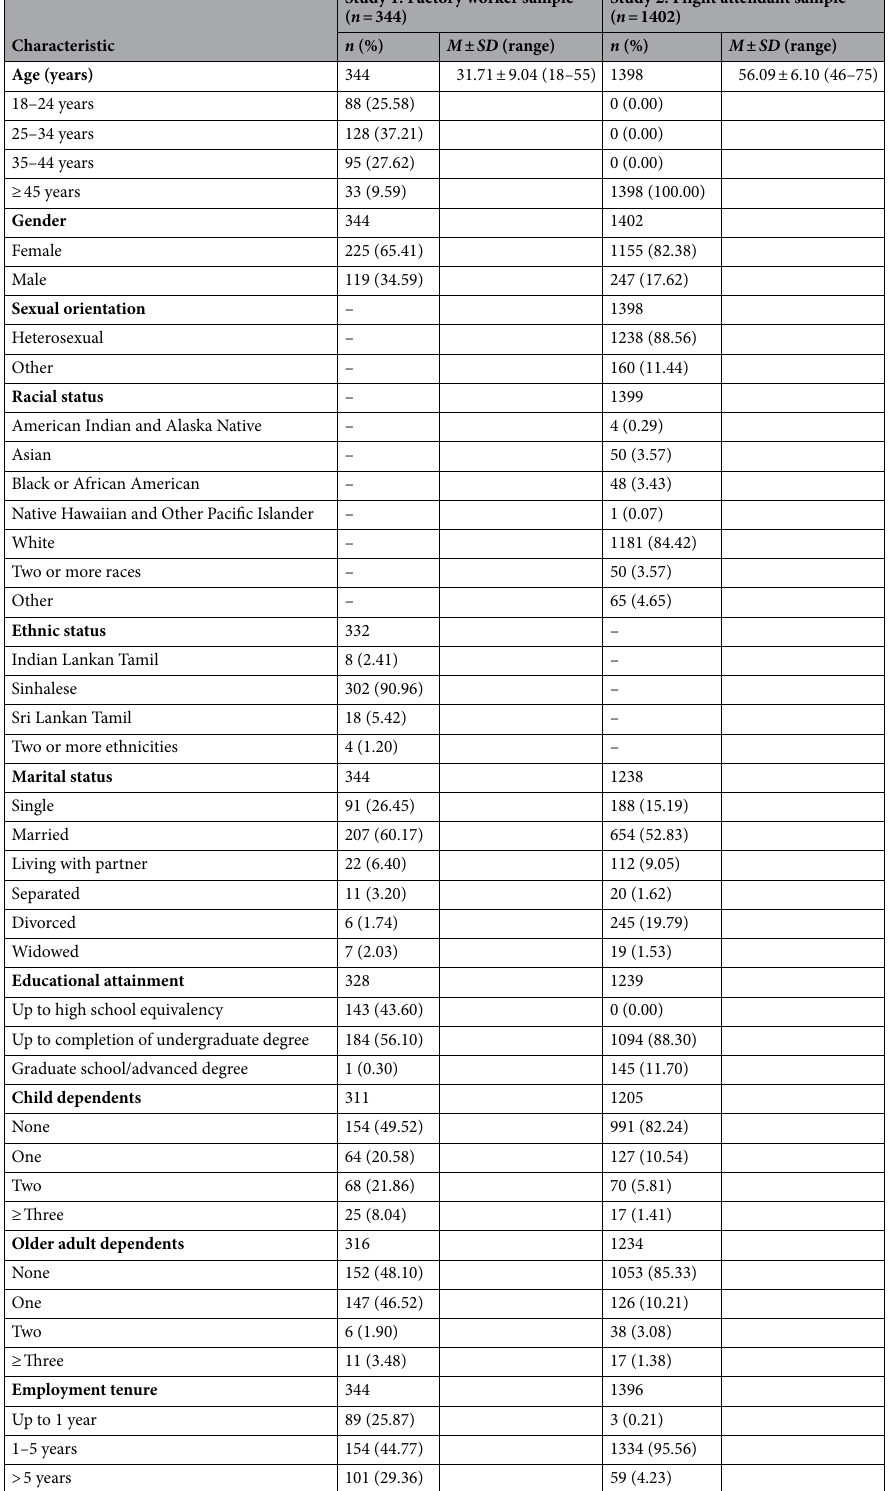
Table 1. Distribution of participant characteristics in Study 1 (factory worker sample) and Study 2 (flight attendant sample). M mean, SD standard